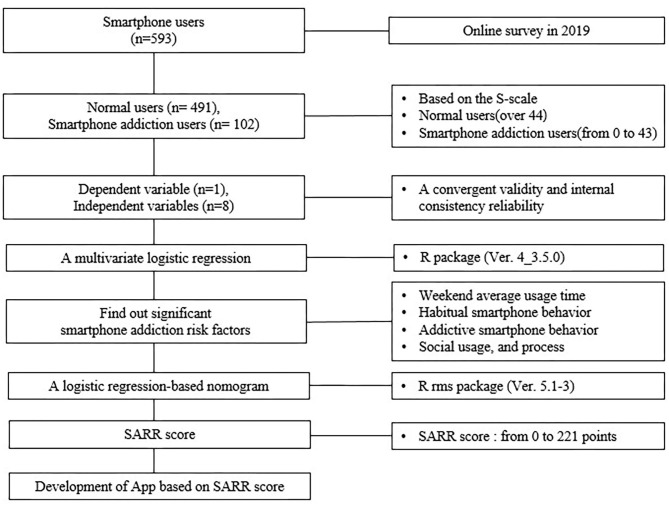
Research process.